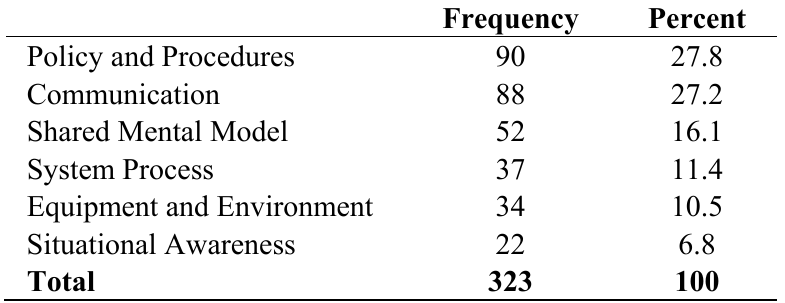
Table 8. Breaches in defensive barriers: location and size of holes